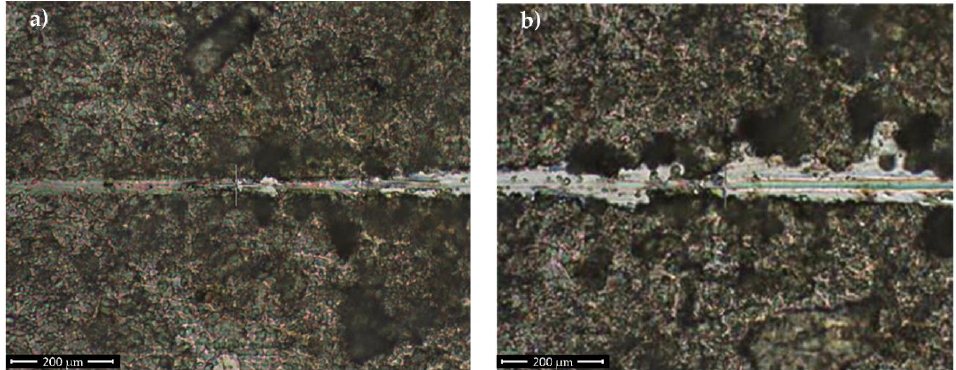
Figure 4. Innitial delamination ( a ) and first coating detachment ( b ) from SS substrate.